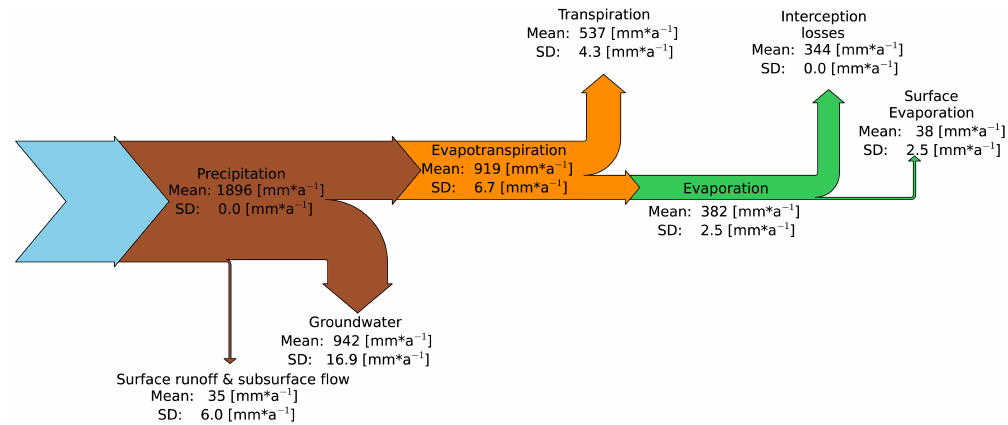
Figure 5. Mean annual flows and standard derivation (SD) of the main flow components at a hillslope scale of all behavioral model runs from 2010 to